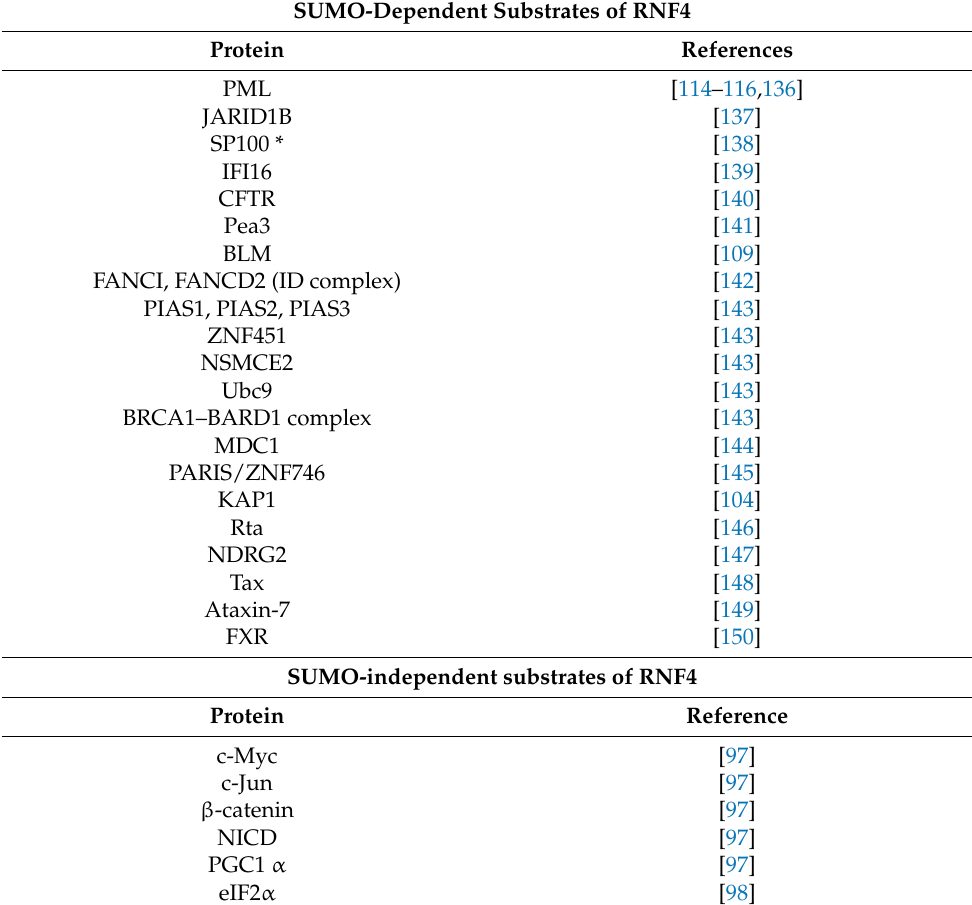
Table 1. Examples of RNF4 substrates. Upper table: Substrates that are recognized once SUMOylated.